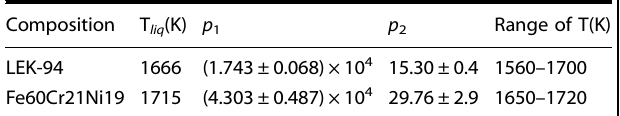
Table 1. Viscosities of molten alloys (Pa ⋅ s) - Arrhenius fi t μ ¼ exp ð p = T (cid:2) p Þ . 1 2